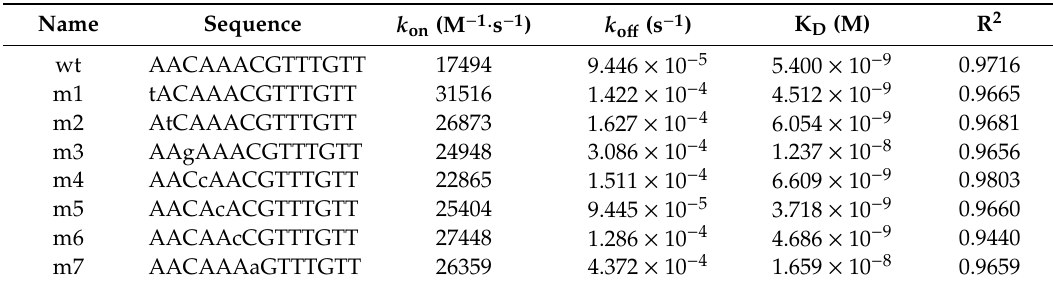
Table 1. TTHA0973-DNA binding parameters.